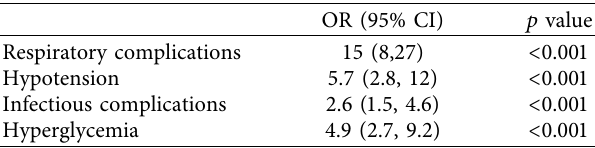
Table 4: Independent risk markers of